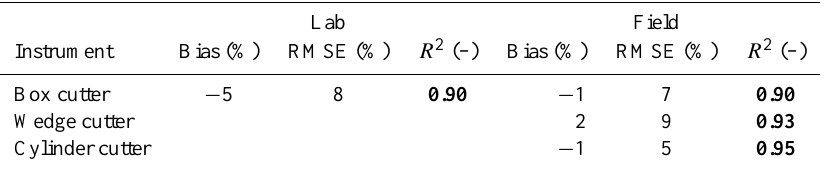
Table 4. Comparison of cutter and µ CT measurements in the lab (Fig. 2) and in the field (Fig. 4). Bias/RMSE are expressed in% of the mean µ CT density. Significant agreement ( p val < 0 . 01) is indicated by bold numbers.